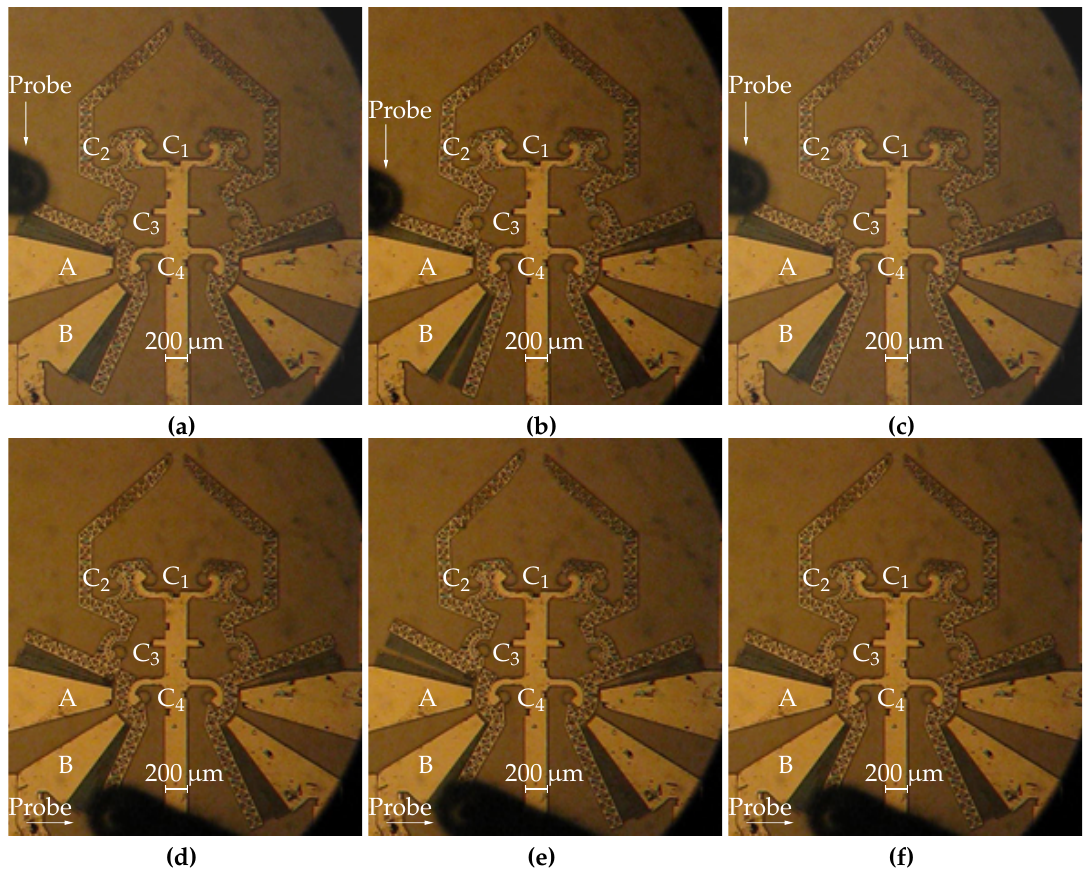
Figure 3. Steps of the mechanical testing procedure: ( a ) Probe positioning near the closing comb-drive (A); ( b ) Close configuration: stroke limit for the closing comb-drive (A); ( c ) Neutral configuration: releasing of the closing comb-drive (A); ( d ) Probe positioning near the opening comb-drive (B); ( e ) Open configuration: stroke limit for the opening comb-drive (B); ( f ) Neutral configuration: releasing of the opening comb-drive